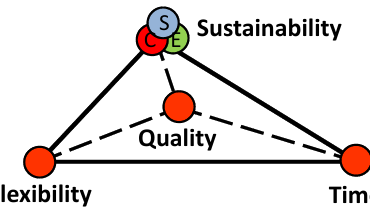
Figure 1. Decision-making attributes of manufacturing (social (S), cost / economical (C), and environmental (E) dimensions of sustainability).